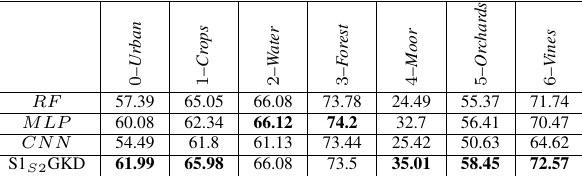
Table 6. Per-Class F-measure for the Dordogne study site. (Average over ten random